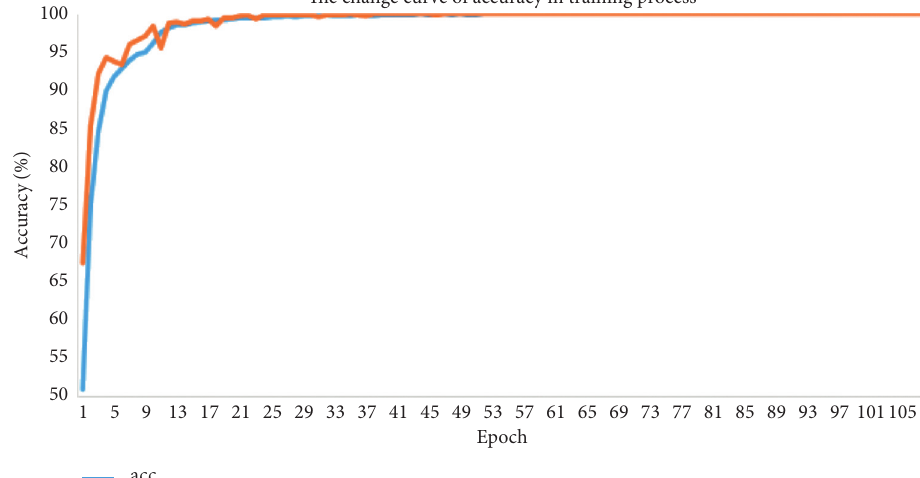
Figure 8: The accuracy of bearing dataset experiment.